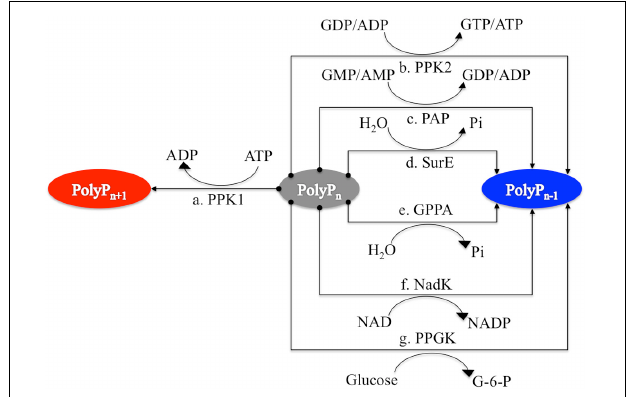
FIGURE 1 | Schematic illustration of seven enzymes involved in polyphosphate synthesis and utilization in prokaryotes. PPK1 represents the synthesis enzyme for polyP metabolism while other six enzymes, PPK2, PAP, SurE, GPPA, NadK, and PPGK, have preferences for polyP degradation although the reactions are reversible. Synthesis pathway is linked to red oval while degradation pathways have linkages with blue